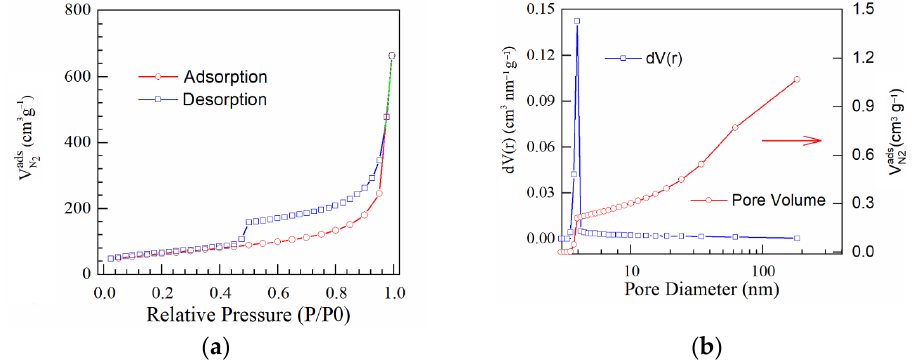
Figure 8. ( a ) N 2 adsorption–desorption isotherms and ( b ) BJH curves corresponding to N/GO_U.